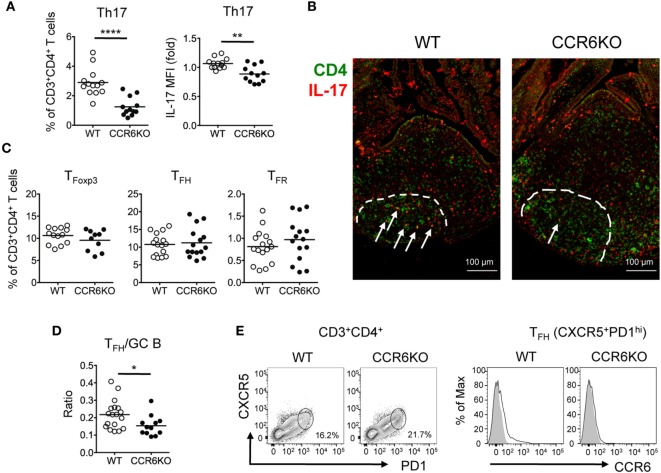
CCR6−/− mice show significantly reduced Th17 cells in Peyer’s patches (PPs). (A) PP lymphocytes were subjected to FACS analysis of Th17 cells (CD3+CD4+IL-17+). The frequency of Th17 in T helper cells (left panel) and the mean fluorescence intensity of IL-17 in Th17 cells (right panel) are shown. (B) Representative immunofluorescence assay of CD4 (green) and IL-17 (red) from paraffin-embedded PPs of WT and CCR6−/− mice are shown. Dash lines indicate GC boundary. Arrows indicate CD4+IL-17+ double-positive cells within germinal centers (GC). (C) FACS analysis of PP lymphocytes. The frequencies of TFoxp3 (CD3+CD4+Foxp3+), TFH (CD3+CD4+CXCR5+PD1+), and TFR (CD3+CD4+CXCR5+PD1+Foxp3+) cells are shown. (D) PP lymphocytes from WT and CCR6−/− mice were prepared and subjected to FACS analysis for detecting TFH (CD3+CD4+CXCR5+PD1+) and GC B (B220+CD95+PNAhi) cells. The absolute cell number of TFH and GC B cells was calculated. The ratio of TFH/GC B was calculated by dividing the absolute cell number of TFH cells by the absolute cell number of GC B cells. (E) Representative contour plots of TFH cells (CD3+CD4+CXCR5+PD1+) in PPs (left panel) and representative histograms of CCR6 expression on TFH cells (right panel) are shown. Each symbol represents one mouse. Data are a compilation of six (A), four (C), or three (D) independent experiments (**p < 0.01; ****p < 0.0001).